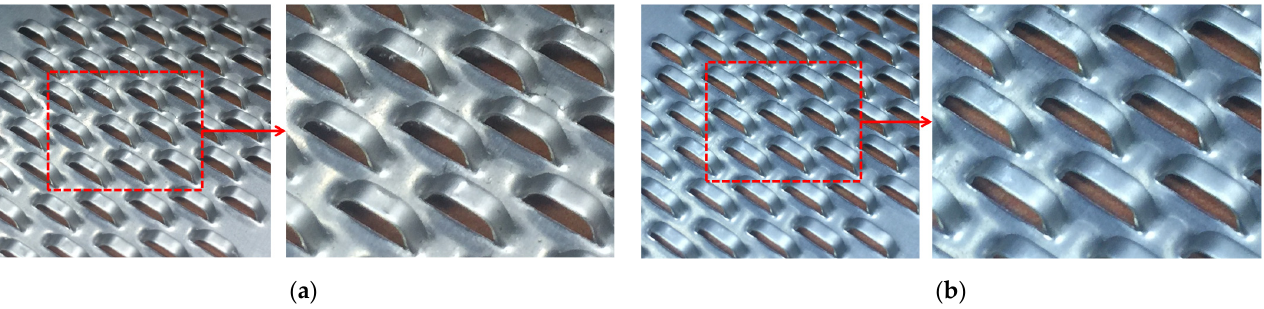
Figure 15. Experimental results of the two-stage forming process: ( a ) slitting-preforming and ( b ) final forming.